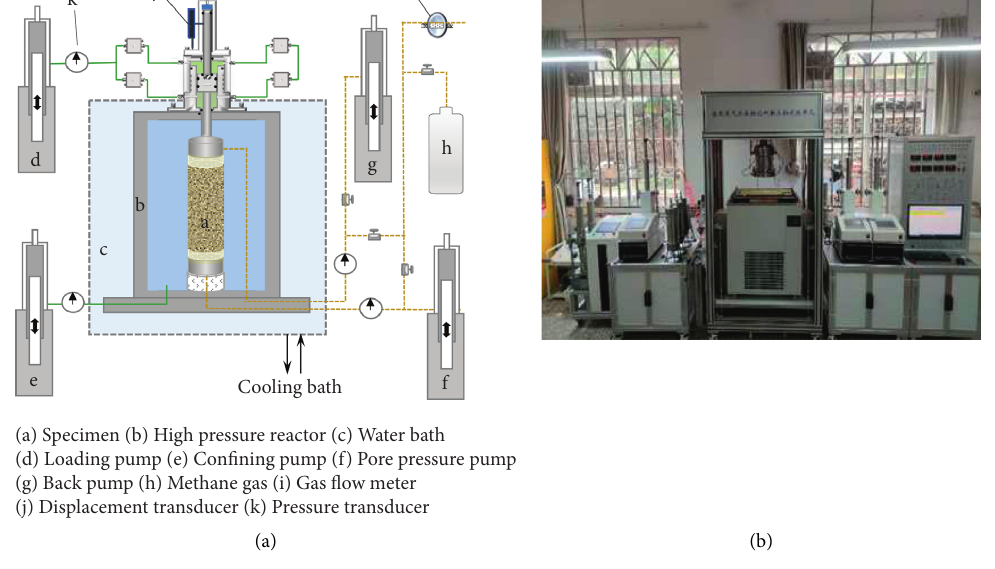
Figure 1: The triaxial testing apparatus for HBS. (a) Schematic diagram. (b) Real diagram.